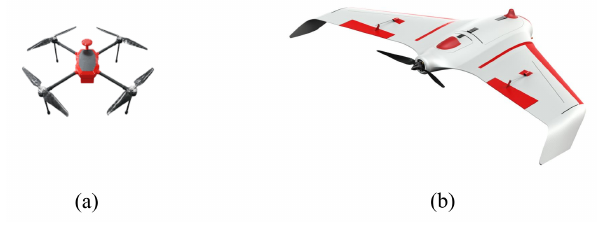
Figure 4. Types of UAVs ( a ) rotary-wing UAV ( b ) fixed-wing UAV. Moreover, UAVs are divided into two groups based on autonomy level: remote control-based and fully